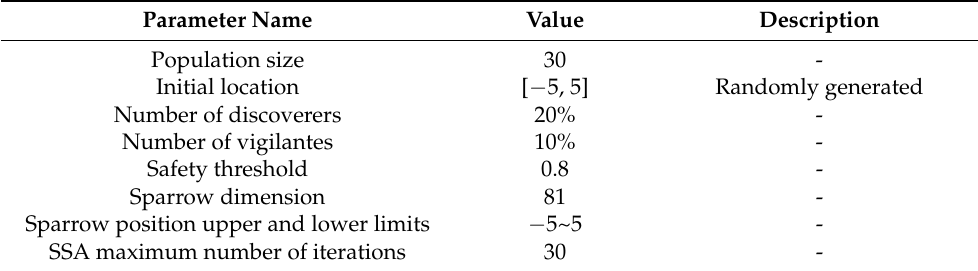
Table 5. Basic parameters of sparrow search algorithm.